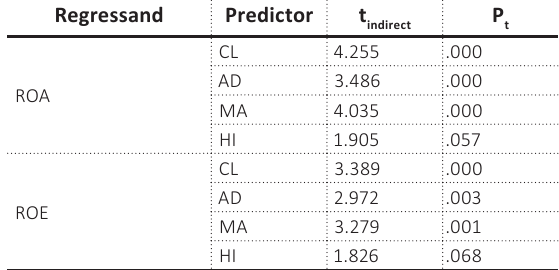
Table 6. Mediation